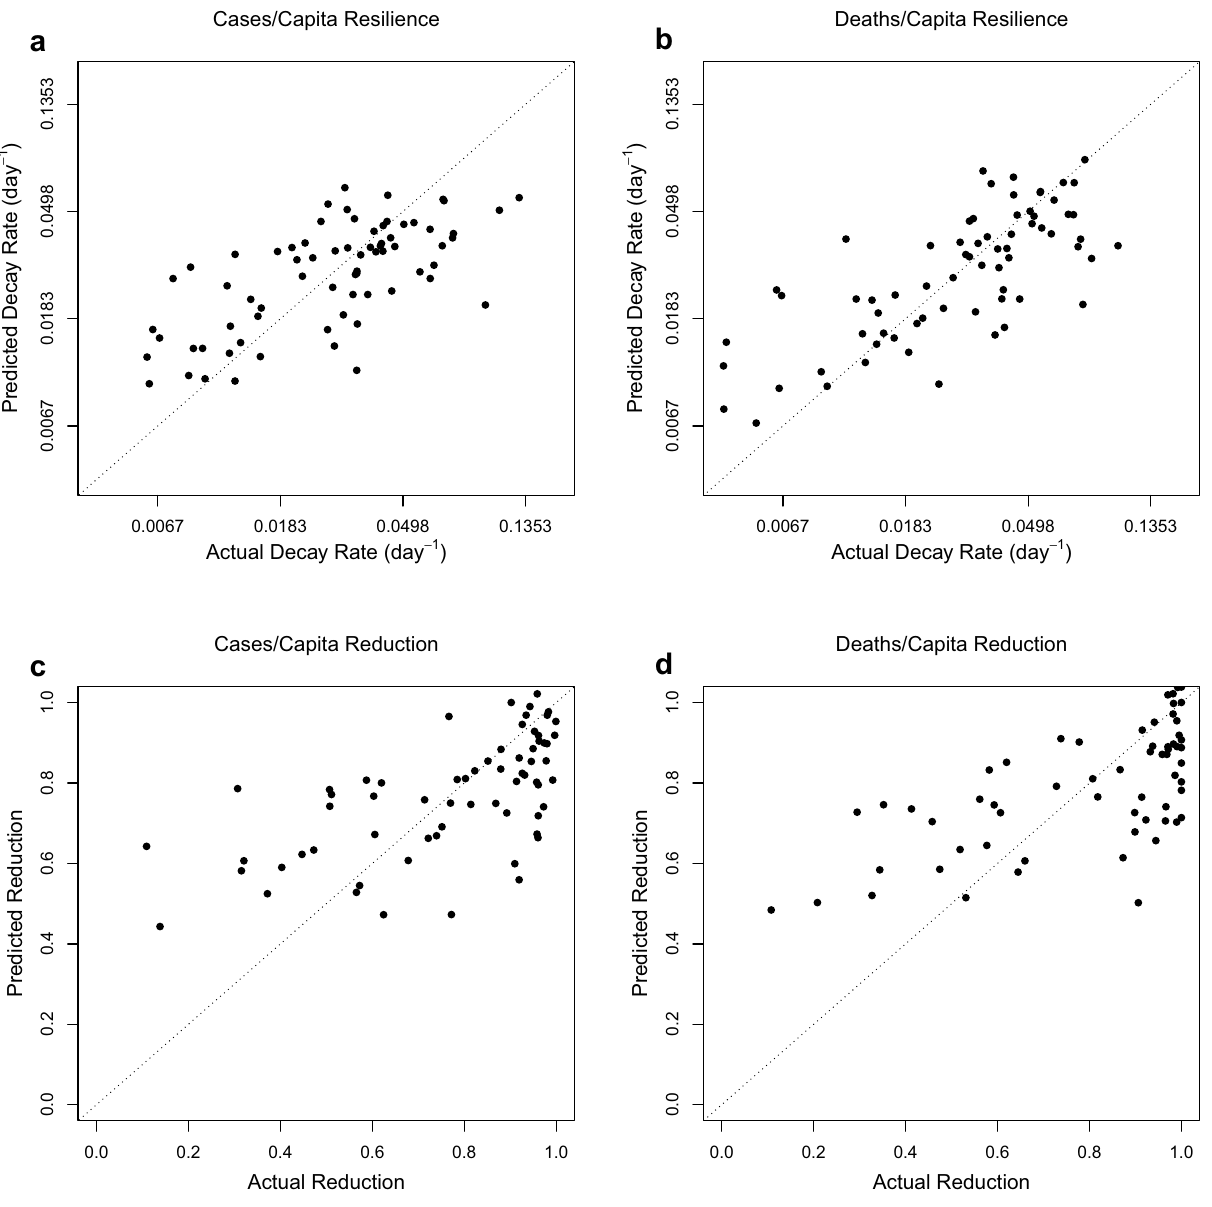
Figure 6. Optimised multiple linear regression models. ( a ) ln(resilience cases/capita) (n = 71, r 2 = 0.409; Supplementary Table 4). ( b ) ln(resilience deaths/capita) (n = 69, r 2 = 0.508; Supplementary Table 5). ( c ) cases/ capita reduction (n = 66, r 2 = 0.352; Supplementary Table 6). ( d ) deaths/capita reduction (n = 66, r 2 = 0.414; Supplementary Table